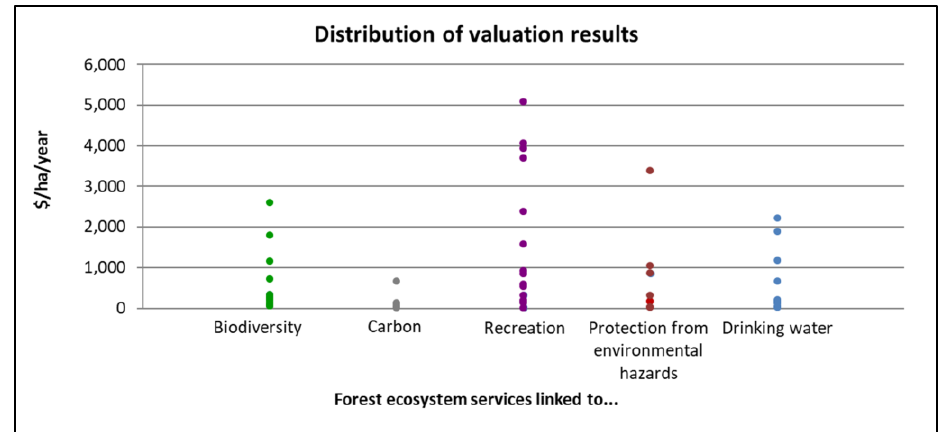
Figure 5. Distribution of economic valuation results extracted from the developed database. (Existing values above 6000 $/ha/year are omitted in the figure for presentation